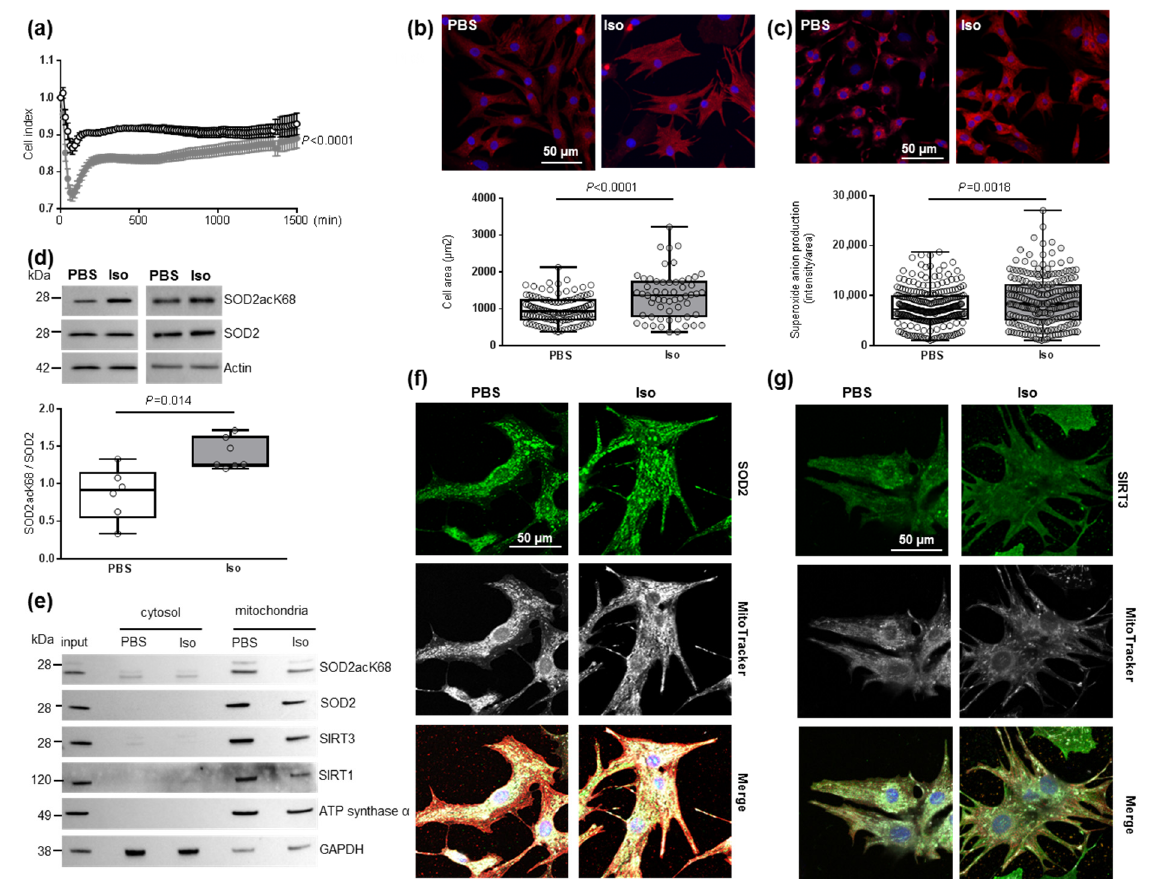
Figure 1. Characterization of mitochondrial oxidative stress in hypertrophied neonatal rat cardiomyocytes (NCMs). ( a ) Cell index quantification in untreated (black line) and Isoproterenol (Iso)-treated (gray line) NCMs by RTCA analysis. Cell index was recorded every 15 min ( n = 4 independent isolation, in duplicate). ( b ) Hypertrophy was quantified in untreated- (PBS) (white box) or Iso-treated (gray box) NCMs for 24 h by immunofluorescence of alpha-actinin (red) and nuclei (blue) (top panels) and quantification of cell area (µm 2 ) (bottom panel) (from 3 independent experiments and at least 273 cells). Oxidative stress was quantified in untreated (PBS) or Iso-treated NCMs for 24 h by fluorescence quantification of ( c ) mitochondrial superoxide anion with mitoSOX probes (red) (from 3 independent experiments and at least 236 cells) and by Western blot of ( d ) SOD2 acetylated on lysine 68 (SOD2acK68) or lysine 122 (SOD2acK122) on SOD2 ratio normalized to actin. ( e ) Representative images of SOD2acK68, SOD2 and sirtuins localized in mitochondria (validated by ATP synthase α ) after subcellular fractionation of untreated (PBS) or Iso-treated-NCMs for 24 h. Representative images of ( f ) SOD2 (green) and ( g ) SIRT3 (green) localized in mitochondria (white) of untreated (PBS) or Iso-treated NCMs for 24 h. Colocalization appeared in merged images. Only significant p values are indicated from at least 3 independent experiments. Images were selected to represent the mean values of each condition.